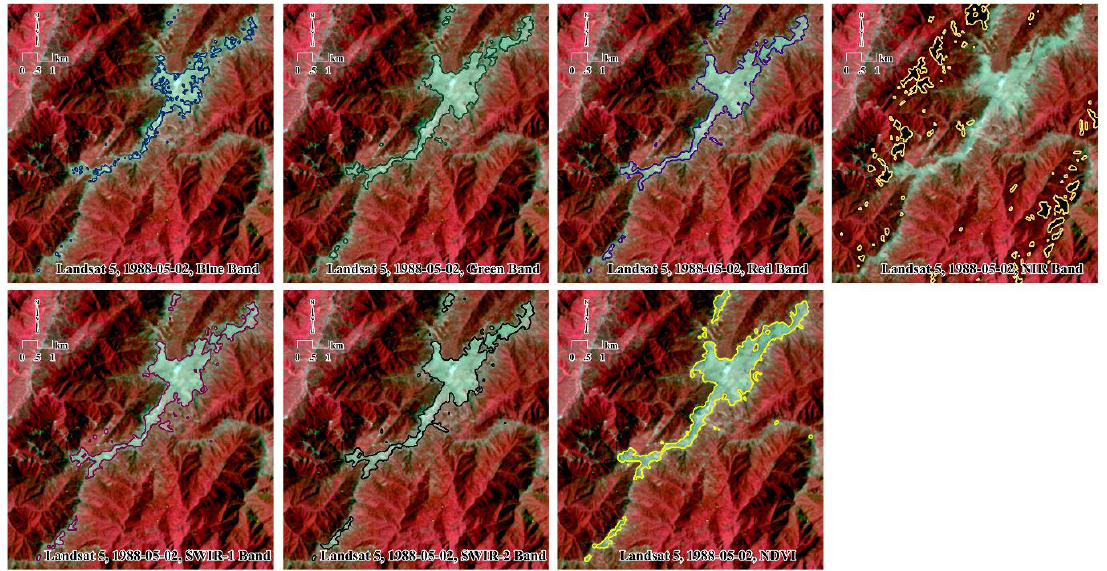
Figure 5. Automatic tree line extraction results from NDVI and Landsat imagery bands using methods based on the concept of local indicator of spatial autocorrelation (LISA).